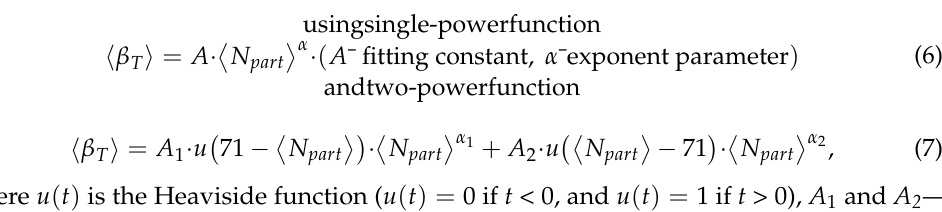
char. pions (Table 2) char. kaons (Table 2) (anti)protons (Table 2) char. pions (Table 3) (anti)protons (Table 3) char. kaons (Table 3)